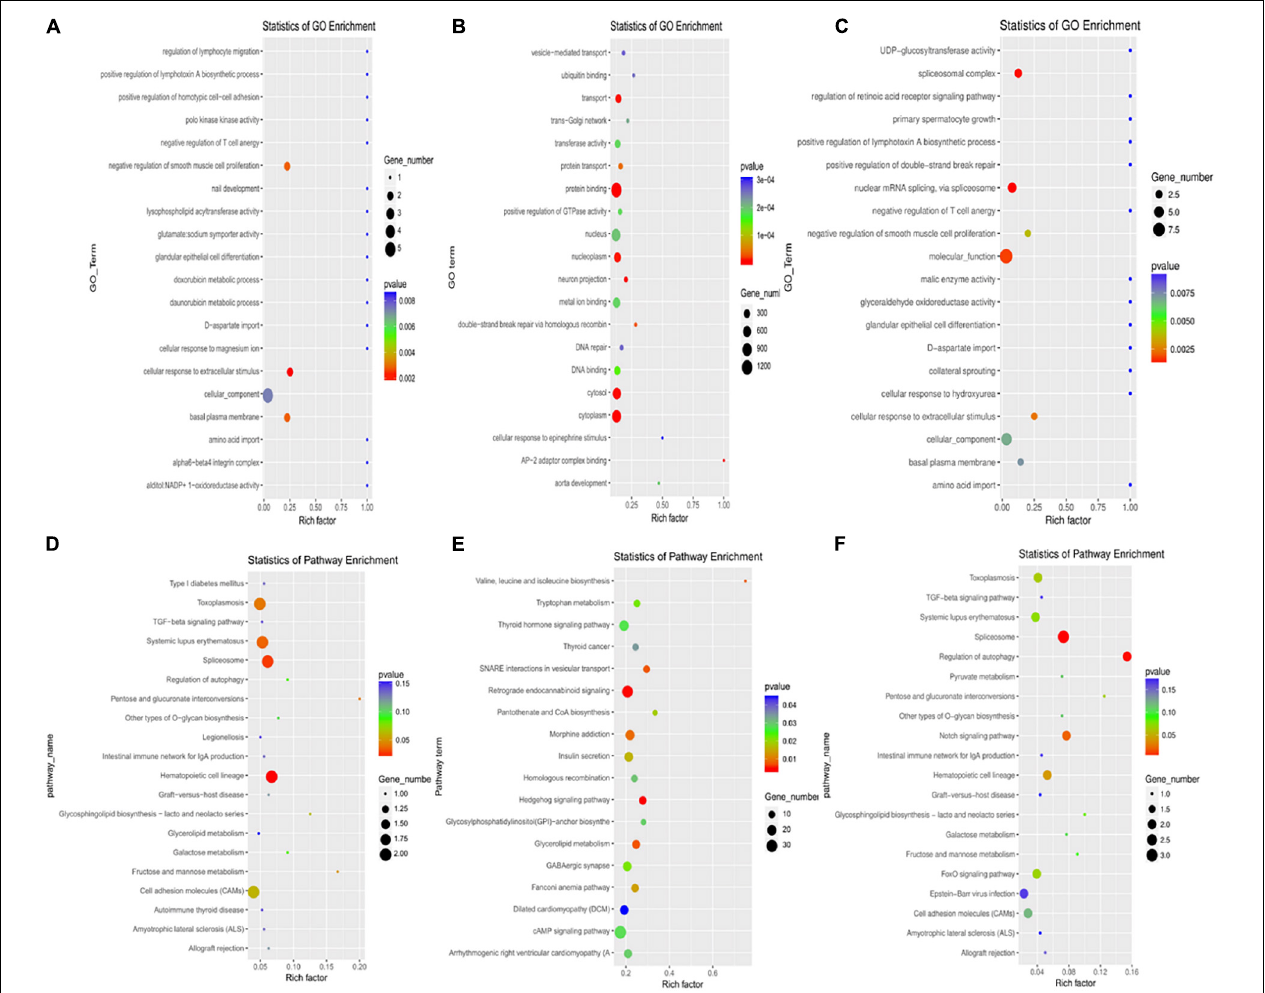
FIGURE 2 | Differentially expressed lncRNAs, miRNAs, and mRNAs GO enrichment scatter plots and KEGG enrichment scatter plots in plasma of rare-earth pneumoconiosis patients. (A) Differentially expressed lncRNA GO enrichment. (B) Differentially expressed miRNA GO enrichment. (C) Differentially expressed mRNA GO enrichment. (D) Differentially expressed lncRNA KEGG enrichment. (E) Differentially expressed miRNA KEGG enrichment. (F) Differentially expressed mRNA KEGG